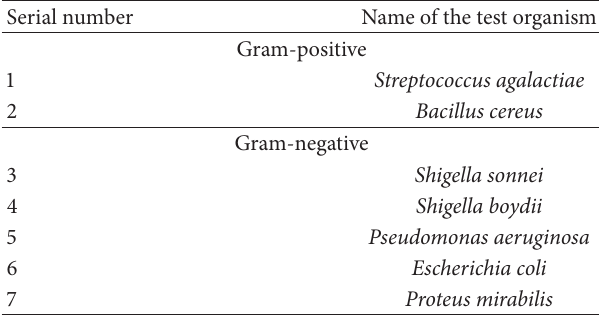
Table 1: The list of pathogenic bacteria used in the